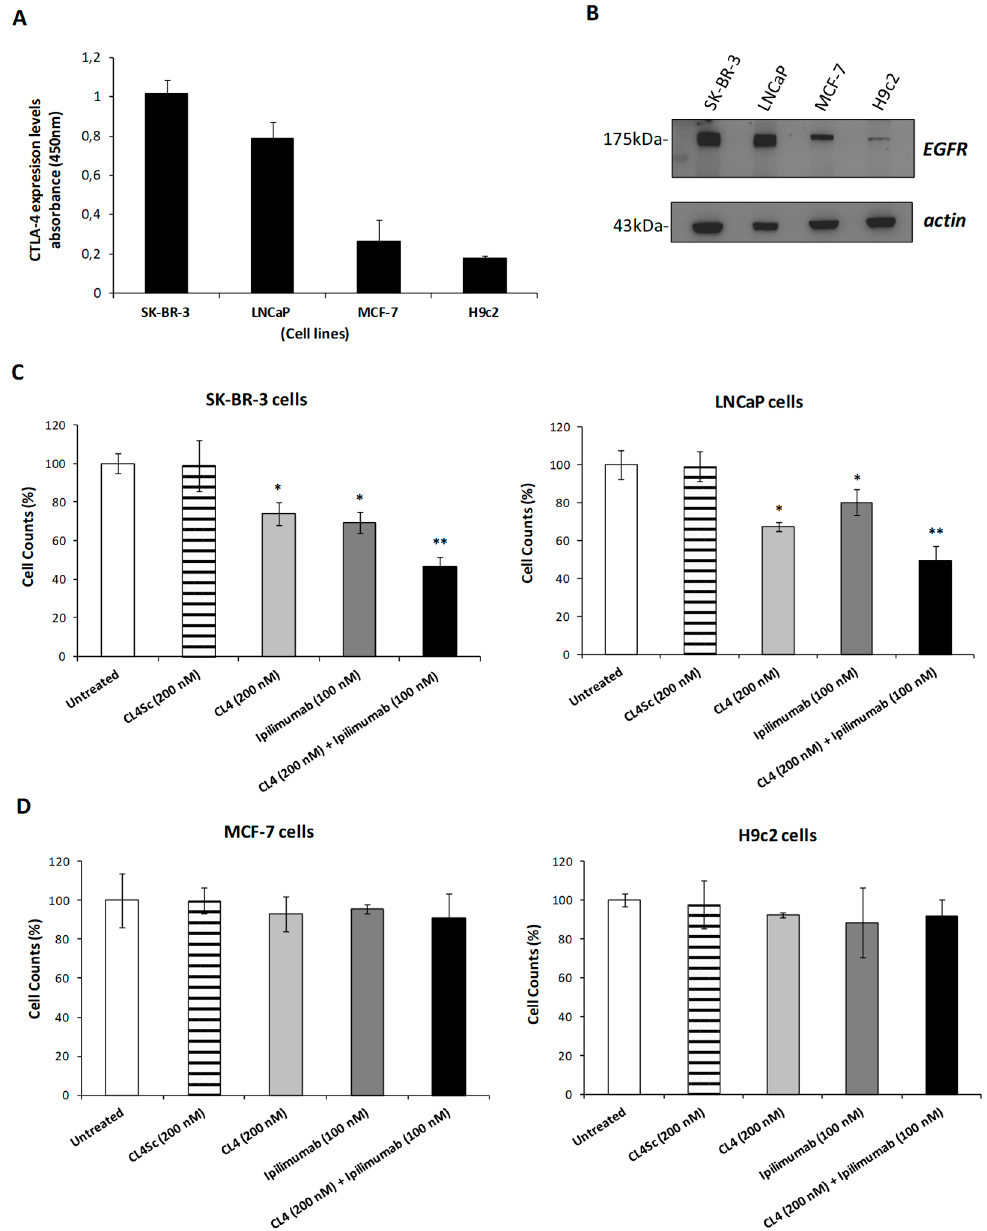
Figure 1. Effects of CL4 aptamer and ipilimumab mAb on tumor cells expressing different levels of CTLA-4 and EGFR. ( A ) Cell ELISA assays on SK-BR-3, LNCaP, MCF-7 tumor cells, and H9c2 cardiomyoblasts by using the anti-CTLA-4 mAb ipilimumab to measure the cell surface CTLA-4 expression level. ( B ) Western blotting analysis with the commercial anti-EGFR mAb of extracts from SK-BR-3, LNCaP, MCF-7, and H9c2 cells. The intensity of the bands was normalized to actin by calculating the ratio of EGFR/actin signal intensities for each cell extract that was found to be 4.5 for SK-BR-3, 5.2 for LNCaP, 0.7 for MCF-7, and 0.07 for H9C2, respectively. ( C,D ) CL4 aptamer (light grey bars), ipilimumab mAb (dark grey bars), or their combination (black bars) were incubated at the indicated concentrations for 72 hours with SK-BR-3 and LNCaP tumor cells expressing both EGFR and CTLA-4 at high levels, or with MCF-7 and H9c2 cells expressing low levels of the antigens. Untreated cells (white bars) or CL4Sc aptamer (striped bars) were used as negative controls. Error bars depict means ± SD. p-values for the indicated treatments relative to untreated cells are: ** p < 0.01; * p < 0.05.